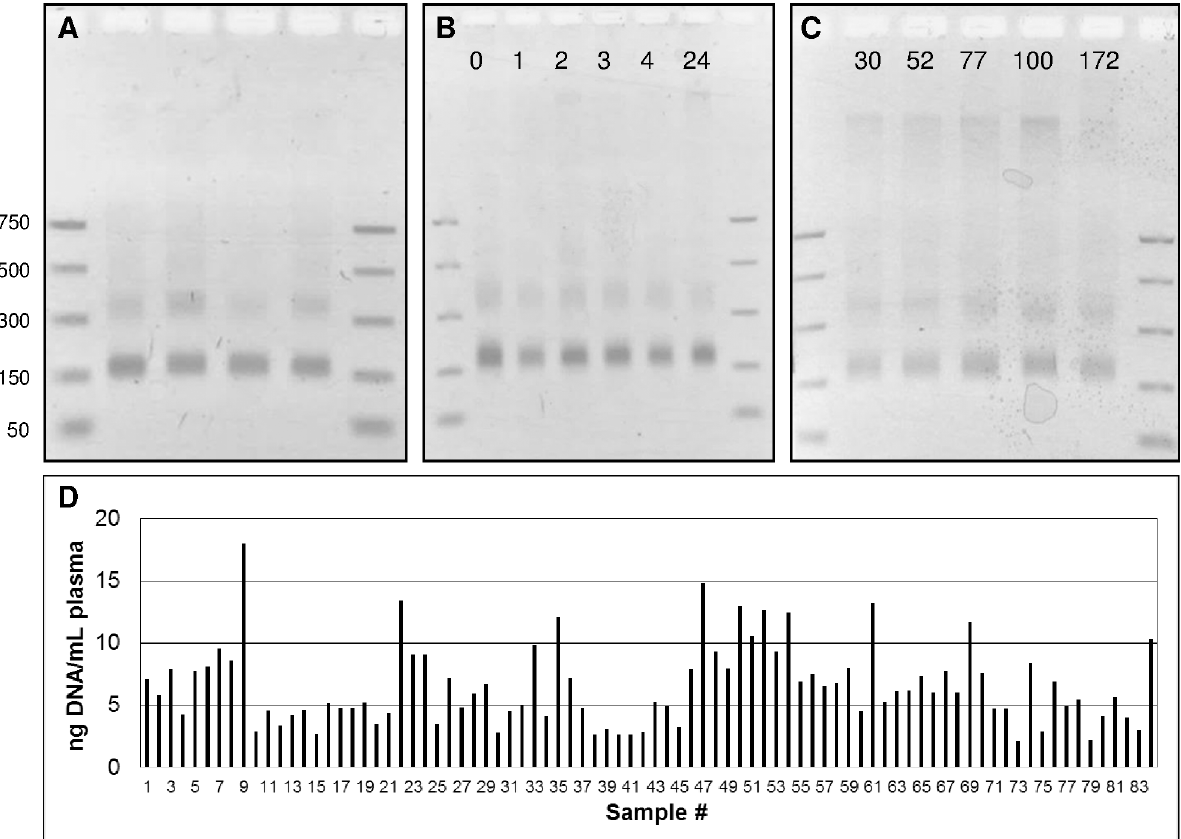
Fig 3. Analysis of cfDNA collected from healthy donors. (A) The cfDNA extracted from four representative healthydonors. (B) The cfDNA extracted from a single donor were processed from wholeblood to plasma at the indicatedtimes (hours). (C) The cfDNA extracted from plasma after storage then shippingof the plasma at the indicatedtimes (hours). (D) The cfDNA yields from 84 healthy